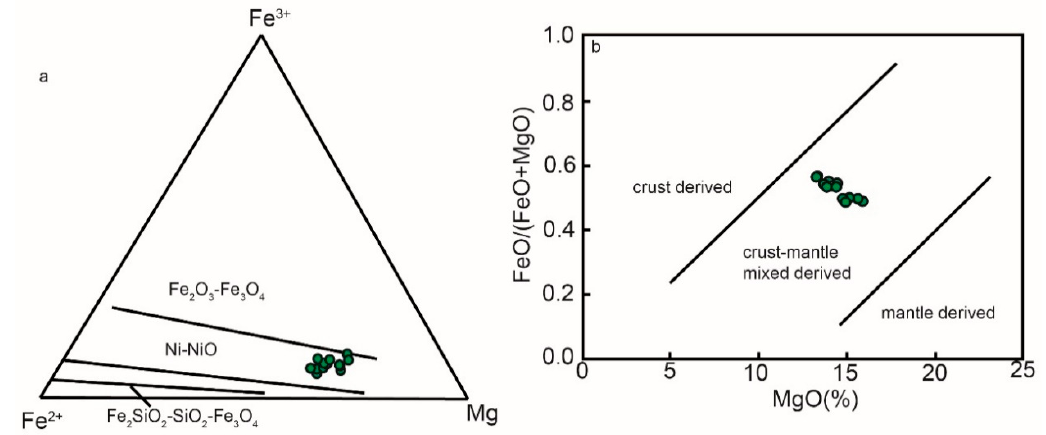
Figure 8. ( a ) Fe 3+ –Fe 2+ –Mg [58], and ( b ) FeO/FeO + MgO vs. MgO for biotites from Hucunnan granodiorite [59].